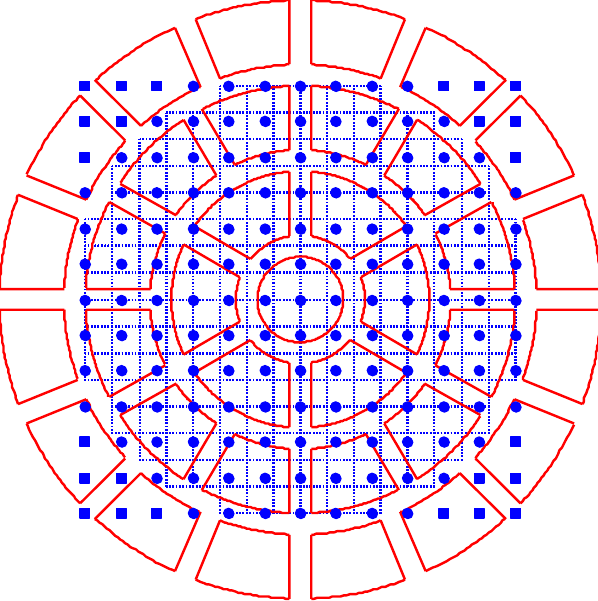
Fig. 7. Layout of bimorph DM, PZT DM and SHWS. The dotted squares represent the lenslets used to sample the pupil, the fan-shaped lines are the locations of the bimorph DM actuators, and the circles show the PZT DM actuator positions and the little squares in the four corners means the PZT DM actuators which are not used in the system.